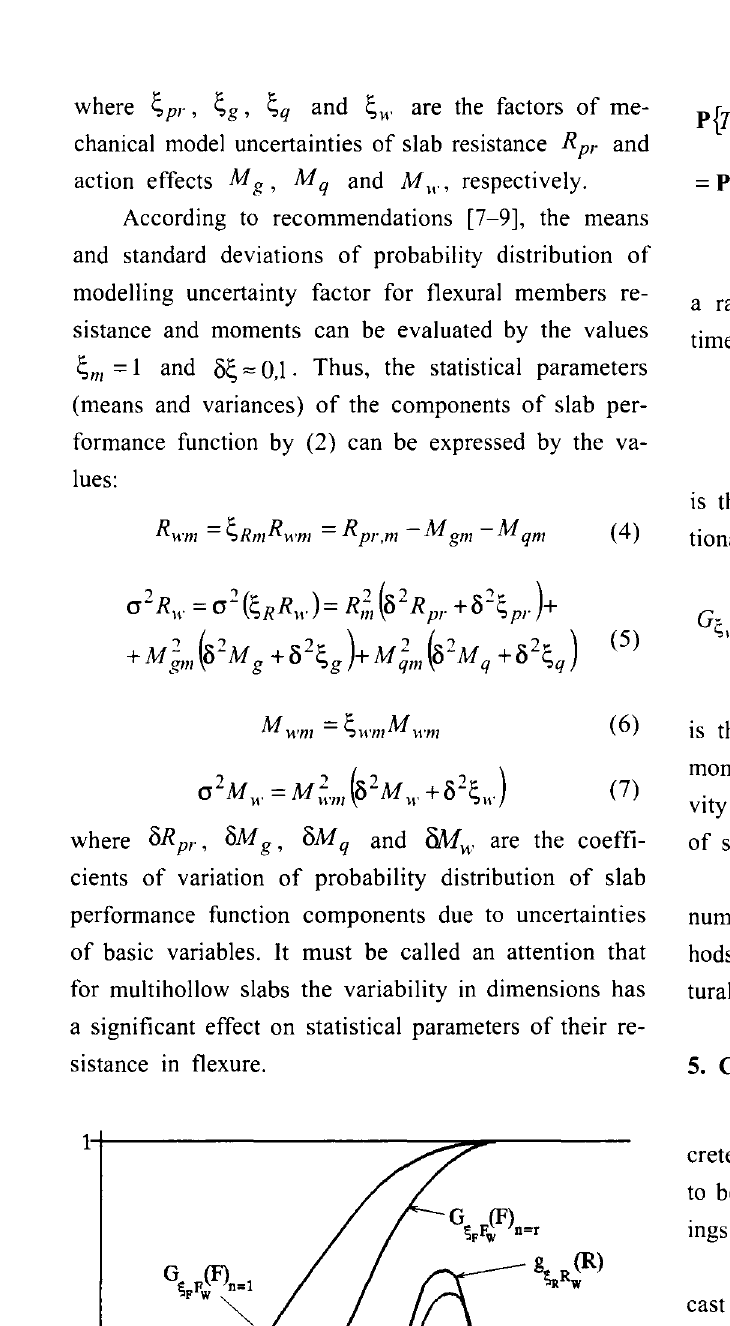
Fig 5. Model for calculation of the slab safety index P{T ~ tr} by